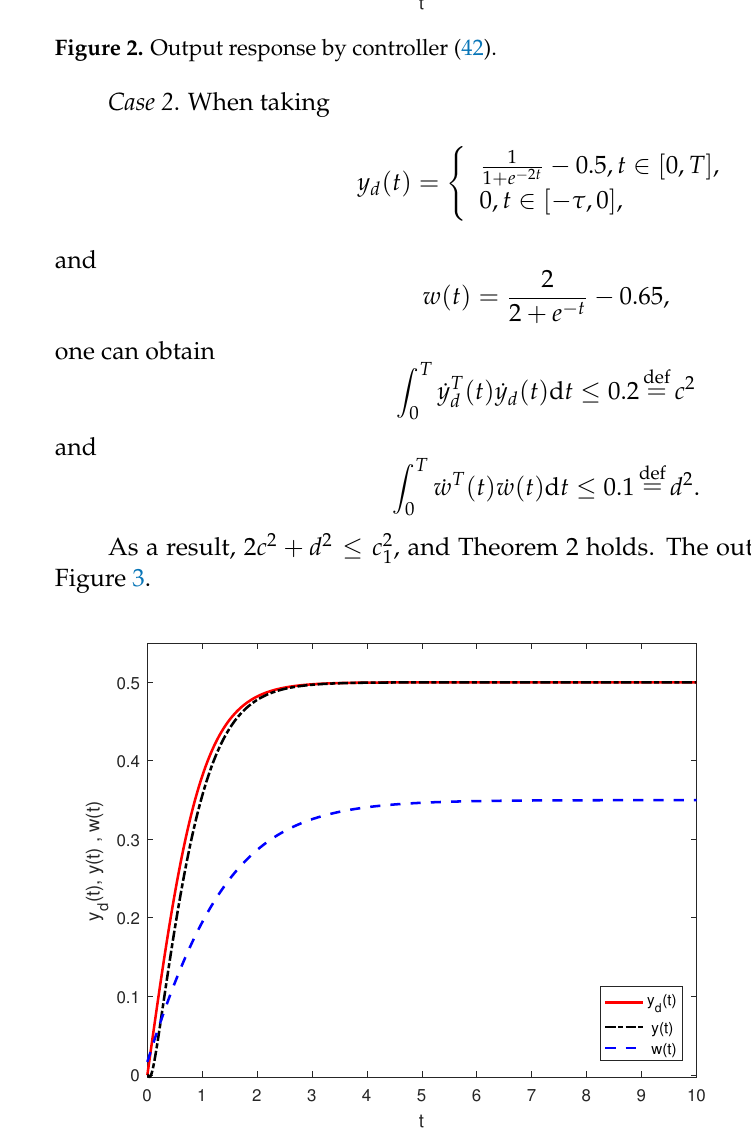
Figure 3. Output response by controller